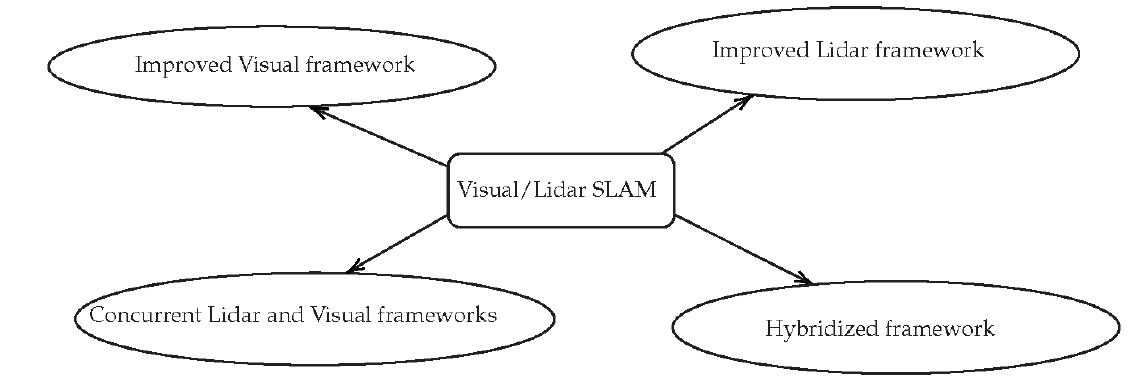
Figure 7. Different ways of implementing visual-LiDAR